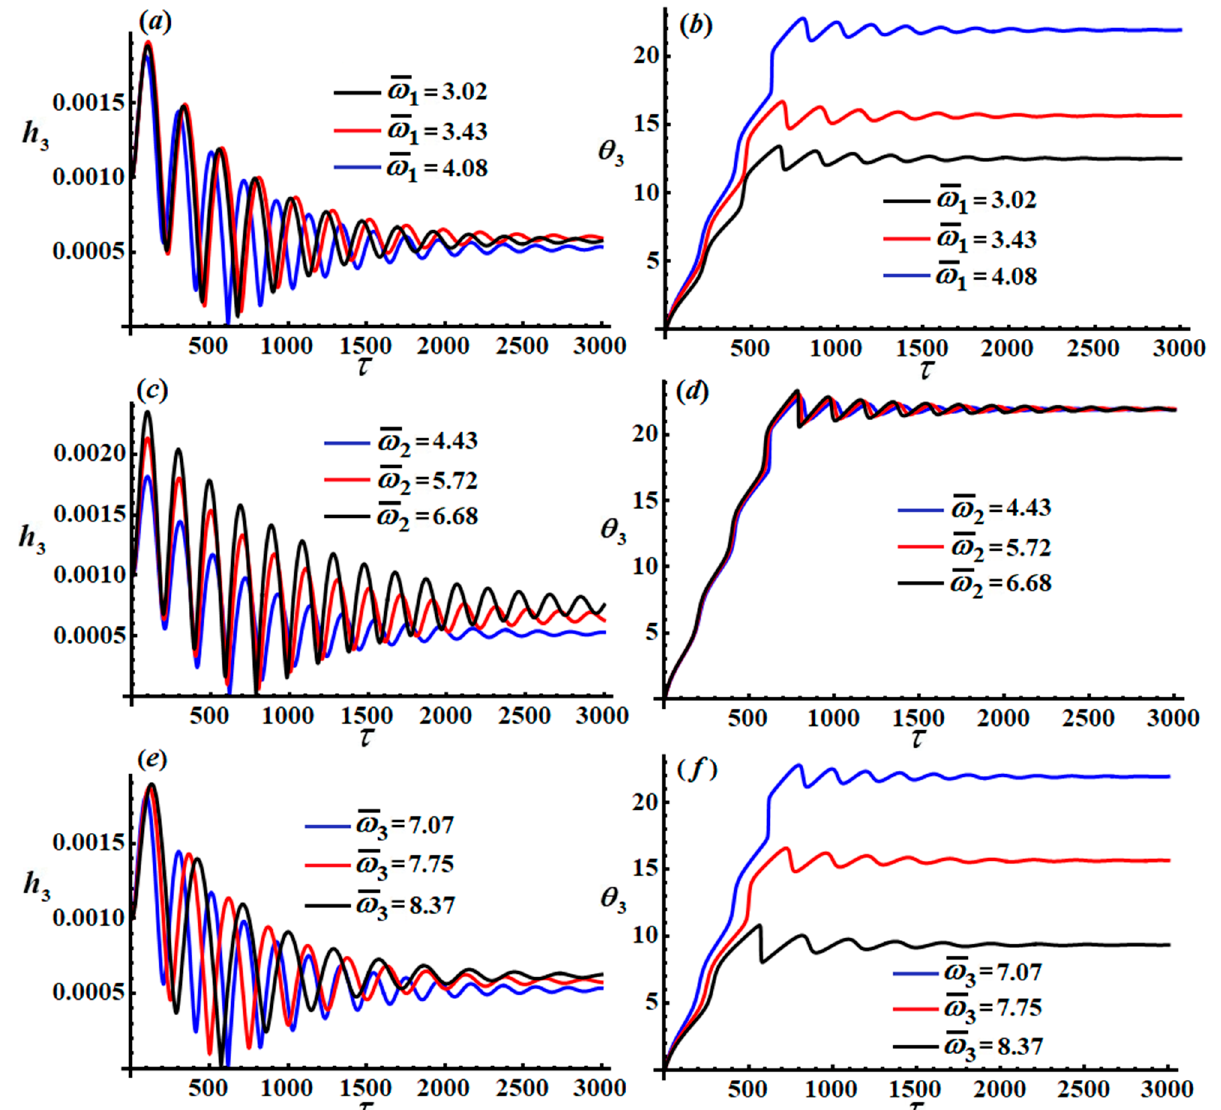
Figure 4. The time histories of the amplitude h ( c , d ) at ω 2 = ( 4.43,5.72,6.68 ) , ( e , f ) at ω 3 = ( 7.07,7.75,8.37 )